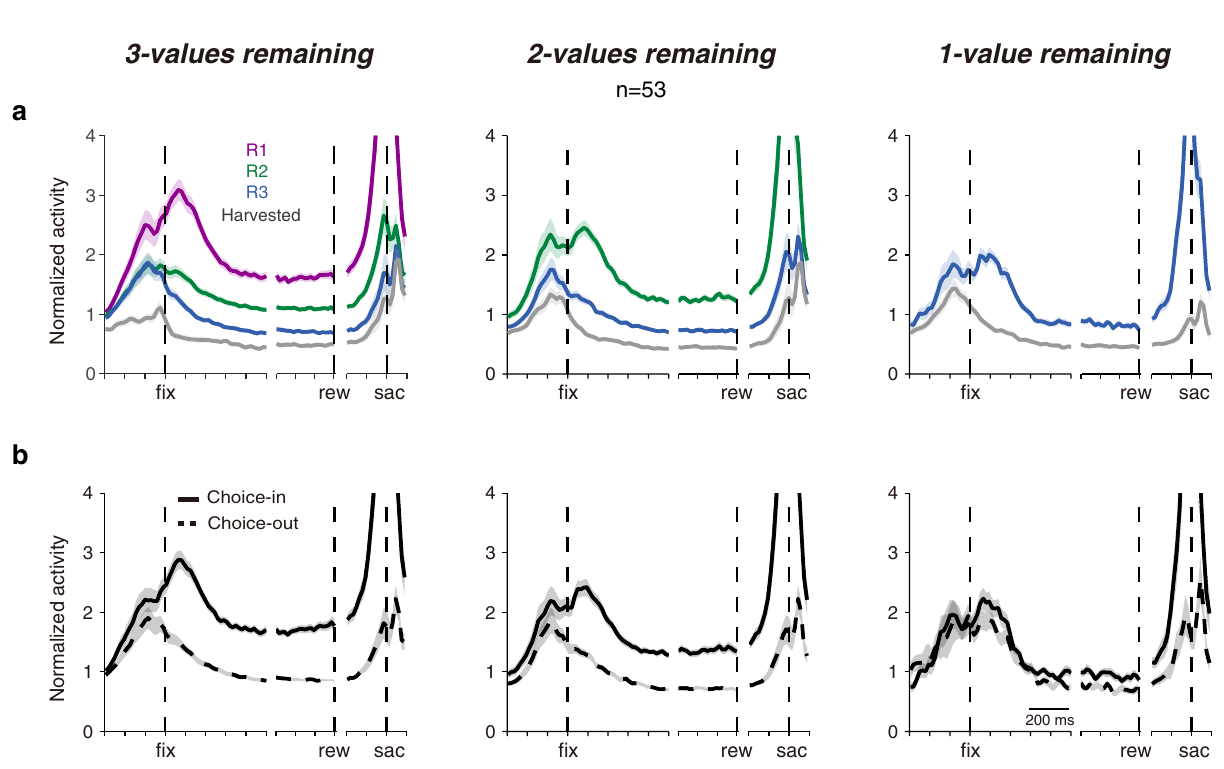
Fig. 3 Population neuronal activity re fl ected target value in the response fi eld and predicted upcoming saccade choice. Note that plots represent a the value of the target in the RF (line color — R1 (purple) denotes highest rank value; R2 (green) denotes middle rank value; R3 (blue) denotes lowest rank value; harvested (gray) denotes previously harvested target with no value), or b choices directed into (Choice-in) or out (Choice-out) of the response fi eld rather than properties of the currently fi xated target. The left side of each panel is aligned on the beginning of fi xation ( fi x), the middle is aligned on reward delivery (rew), and the right is aligned on saccade onset (sac). The total duration of the spike density waveforms could not be shown because the fi xation time varied across targets and experiments. The shaded regions surrounding each line represent SC activity across menus (Fig. 5a). Although the value-threshold between menus after entire value classes were harvested (Supple- level remained constant within a menu regardless of the value of mentary Figs. 5c and 6). Nor did the value of the currently fi xated the chosen target, it systematically decreased across menus target have an effect on value-threshold level across menus (Fig. 5b; n-way ANOVA test, effect of menu, F 2,250 = 16.86, P = (Supplementary Fig. 7). These menu-dependent changes in the 1.4 × 10 − 7 ; see Supplementary Fig. 4a, b for individual monkey value-threshold level were re fl ected in the saccade latency (Fig. 5c; data). This decreasing value-threshold level was not the result of n-way ANOVA test, effect of menu, F 2,258 = 23.8, P = 3.3 × 10 − 10 ; see Supplementary Fig. 4c, d for individual monkey data). As the harvesting individual targets but occurred during the transition